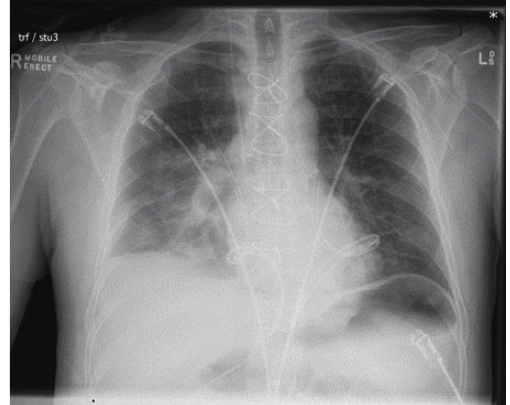
Figure 1: Prebronchoscopy chest X-ray.